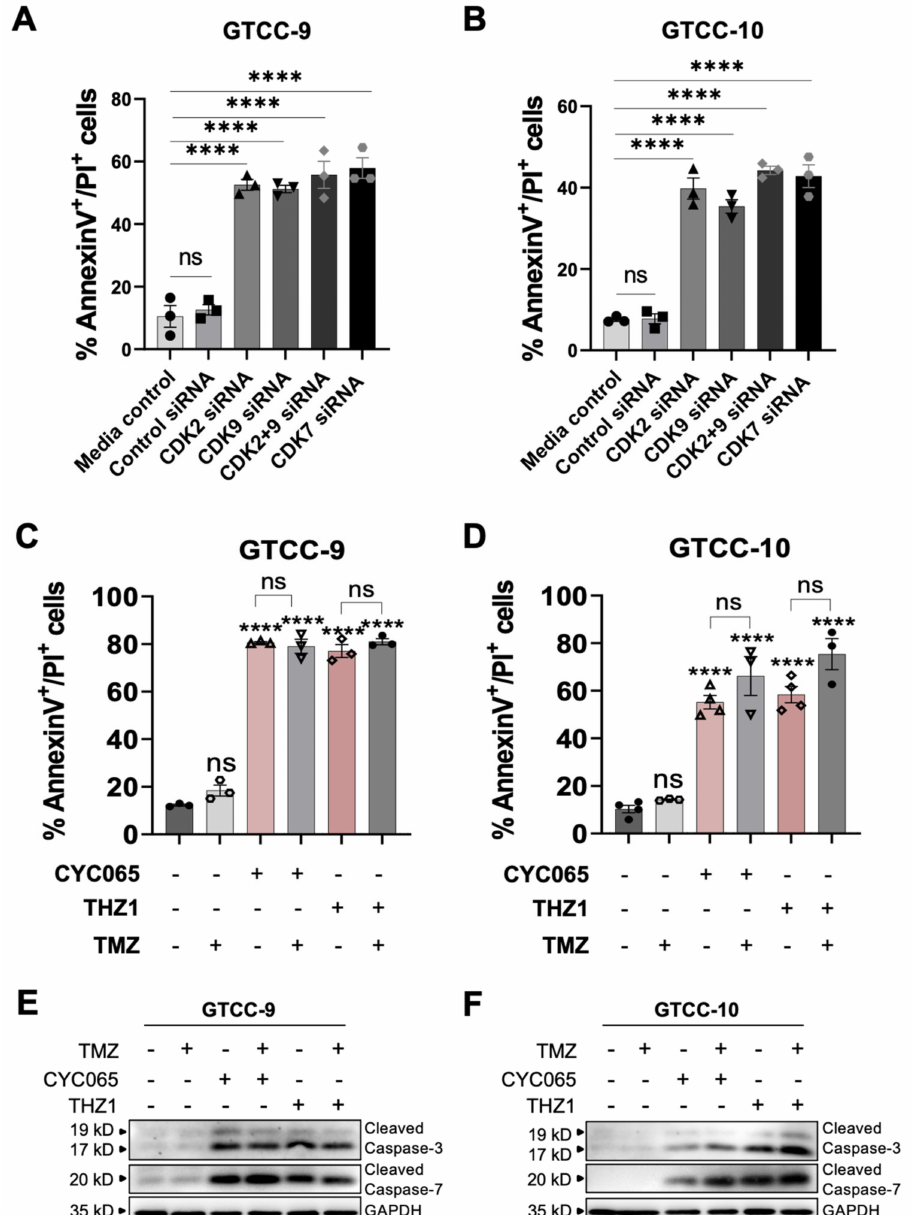
Figure 4. Recurrent gliomaspheres are resistant to TMZ but sensitive to CYC065 and THZ1 as single agents. ( A , B ) Apoptotic cell death was measured using AnnexinV/PI staining in cells transfected with scrambled control siRNA (20 nM), Cdk2 and/or 9, 7-targeting siRNAs (20 nM) (as indicated) in GTCC-9 ( A ) and GTCC-10 ( B ) cultures. Data are expressed as mean ± SEM. One-way ANOVA with post-hoc Tukey’s analysis was used for statistical analysis, whereby, **** p < 0.0001, ns = not significant; n = 3 independent experiments performed. ( C , D ) Apoptotic cell death upon treatment with DMSO, 150 µ M TMZ, 3 µ M CYC065 or 100 nM THZ1 alone or pre-treated with TMZ (150 µ M, 24 h) was determined using flow cytometry AnnexinV/PI staining 120 h post treatment. Data are expressed as mean ± SEM. One-way ANOVA with post-hoc Tukey analysis was used for statistical analysis, whereby, **** p < 0.0001, ns = not significant; n = 3 independent experiments performed in triplicate for each condition. ( E , F ) Caspase activation was followed using Western blot analysis in two recurrent cell lines treated for 120 h with DMSO, 150 µ M TMZ, 3 µ M CYC065 or 100 nM THZ1 alone or pre-treated with TMZ (150 µ M, 24 h). GAPDH was used as a loading control. Western blot analysis was performed for n = 3 biological replicates and representative blots are shown